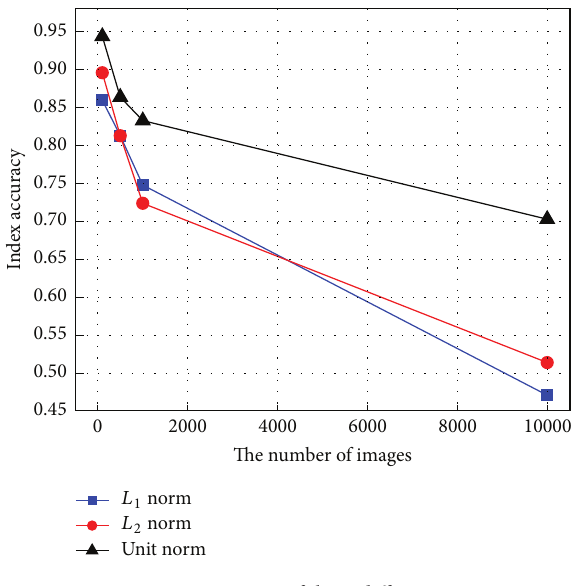
Figure 4: Comparison of three different norms . Table 1: Improvements on discarding invalid descriptors.